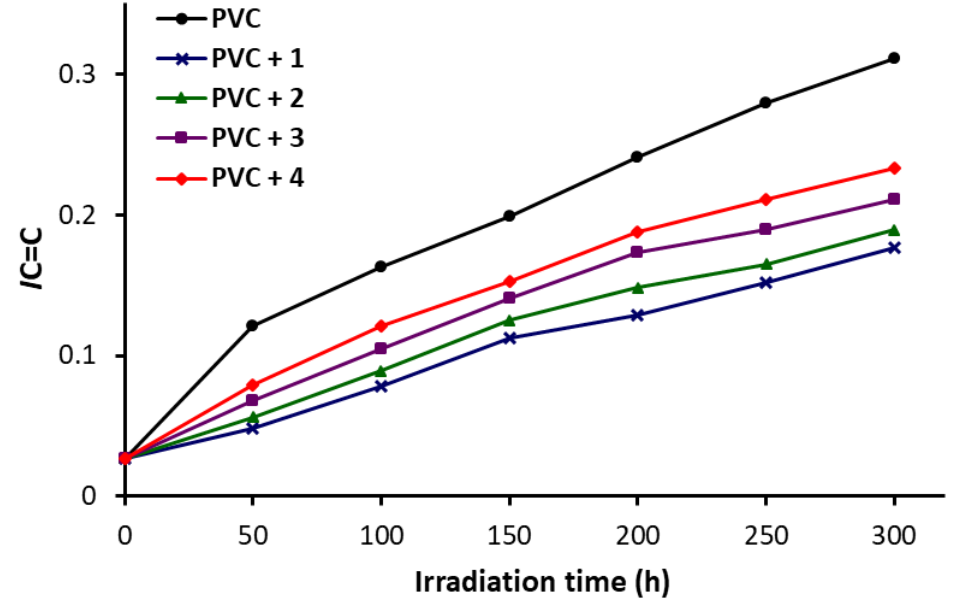
Figure 5. Effect of UV irradiation time on the I C=C of PVC films.